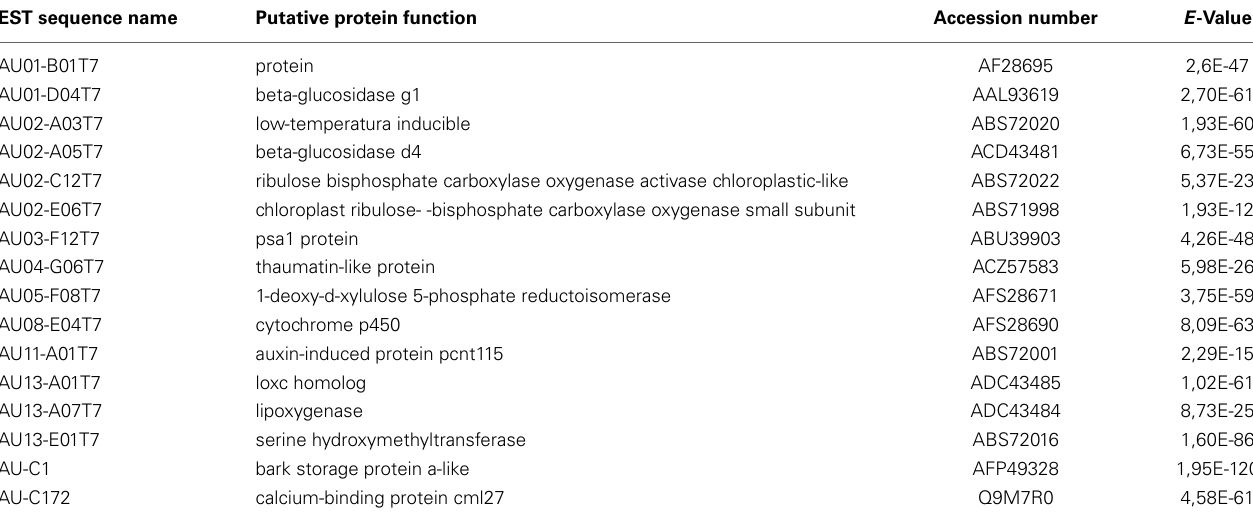
Table 2 | List of induced EST sequences identified after Blastx analysis as homologous to olive ( Olea europaea L.) genes previously indexed in